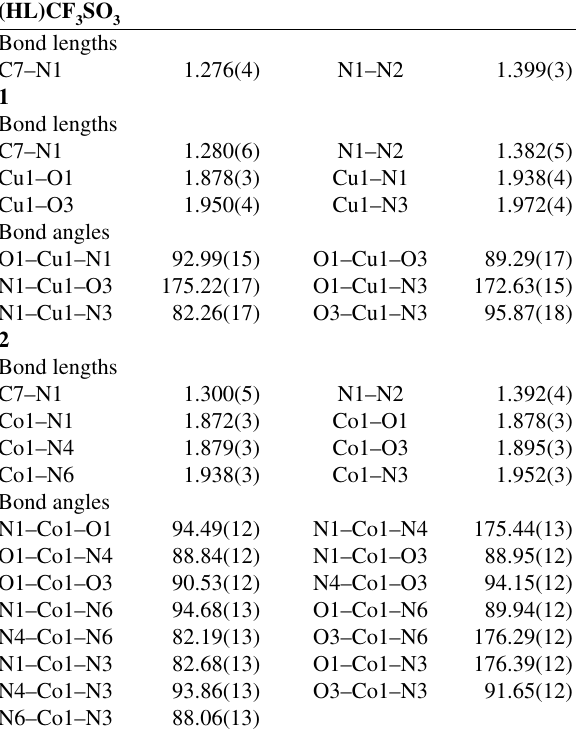
Table 2. Selected bond lengths (Å) and angles (°) for the com- pounds